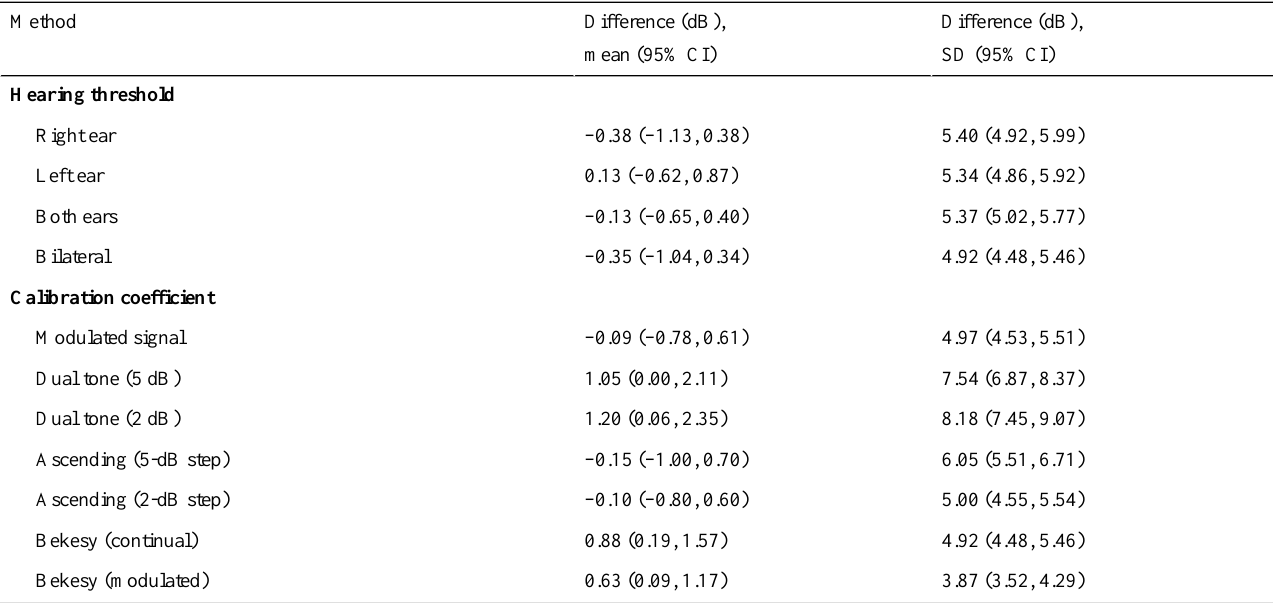
Table 1. Mean difference and standard deviation of the difference with corresponding confidence intervals at P =.05 of hearing thresholds and calibration coefficients between series 1 and 3 calculated jointly for 8 frequencies